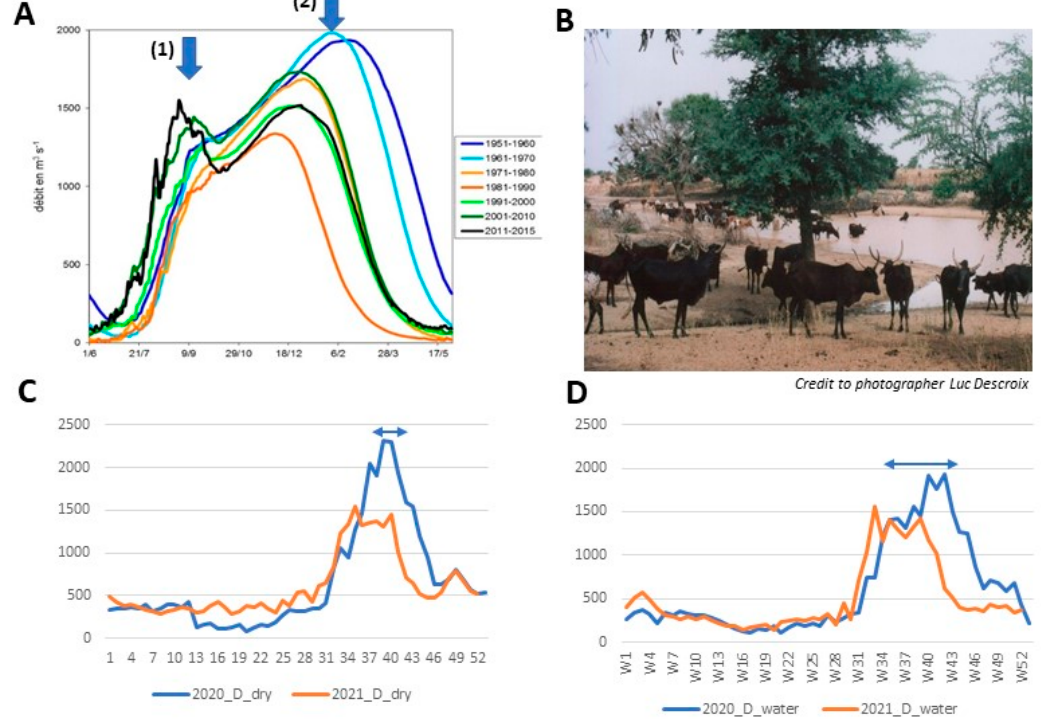
Figure 1. Change over the last 50 years of the two main floods of the Niger river in Niamey and its impact on malaria transmission. ( A ) Decadal evolution of the two floods of Middle Niger river at Niamey gauge station since 1950: (1) first flood due to rainfalls in Niger, (2) second flood due to rainfalls in Guinea. Over time the first pic increases. ( B ) In July, a pond in the Lullemeden sedimentary basin in Niger. Credit to photographer Luc Descroix. ( C ) Confirmed malaria cases registered in dispensaries from Niamey, far from the river. ( D ) Confirmed malaria cases registered in dispensaries closed to the river. Arrows highlight the shift of the transmission between a year with flooding (2020) and a year without flooding (2021). Raw number of cases are recorded and should be related to the population of each area. However, these graphs aim to highlight the shift in the